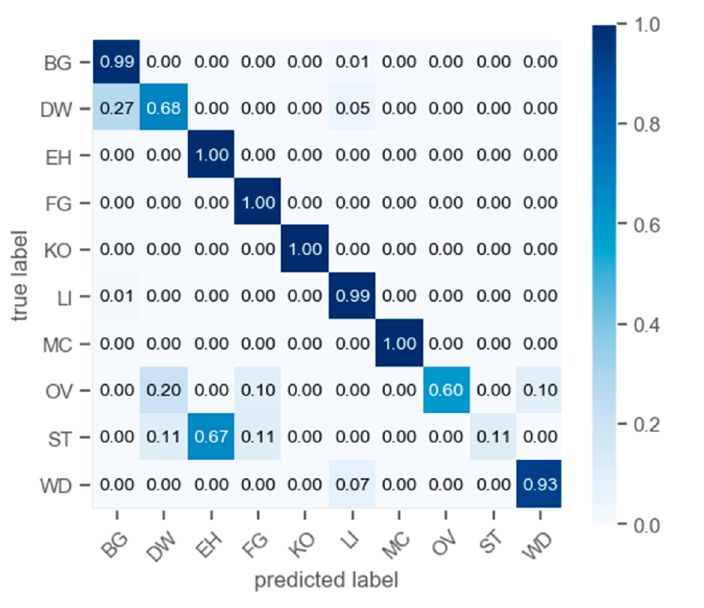
Figure 7. Confusion matrix.